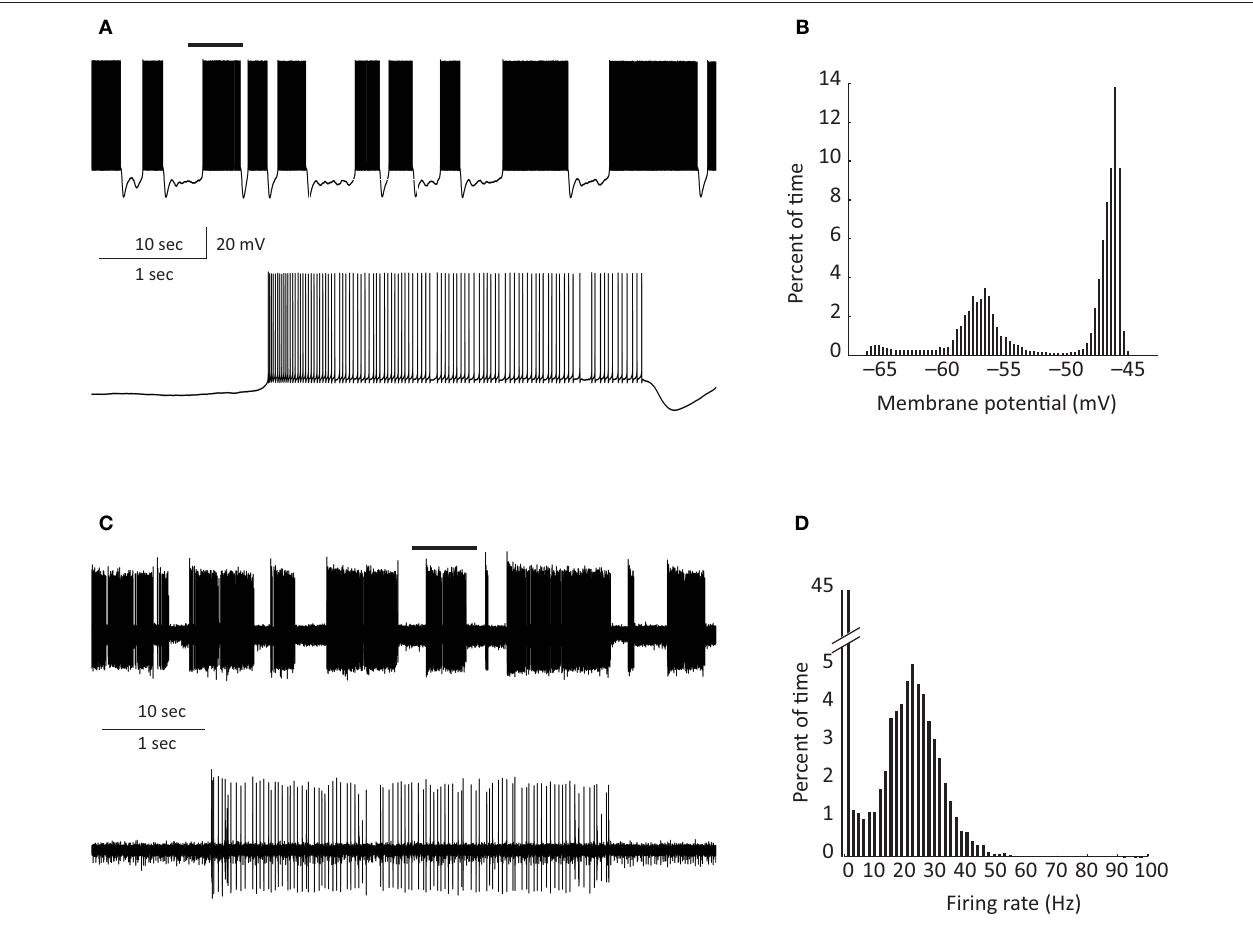
FIGURE 1 | PC bi stability recorded intracellularly in a cerebellar slice (A) and extracellularly in a ketamine anesthetized rat (C) (see Tal et al., 2008 for methods). An epoch of up state (marked by horizontal bars in the upper traces)